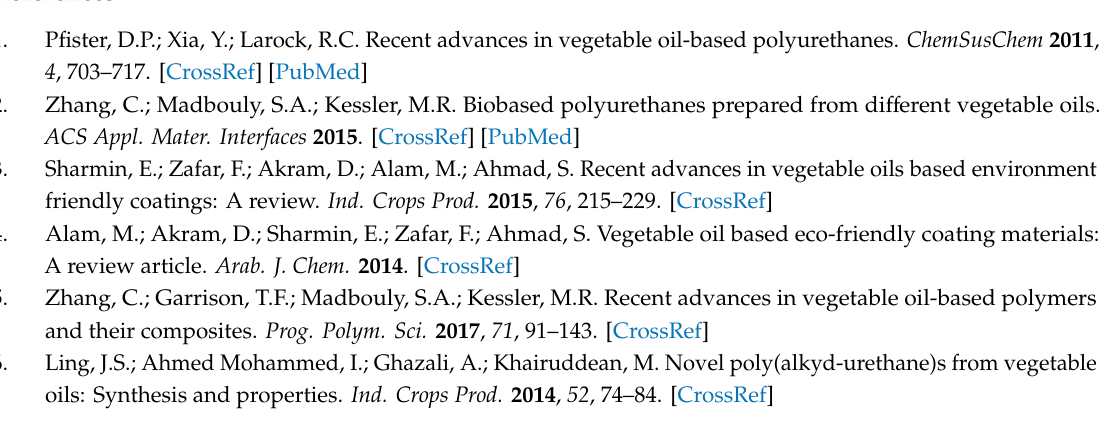
Figure 9. Haze data of JPUA-TDI and JPUA-IPDI-based films.